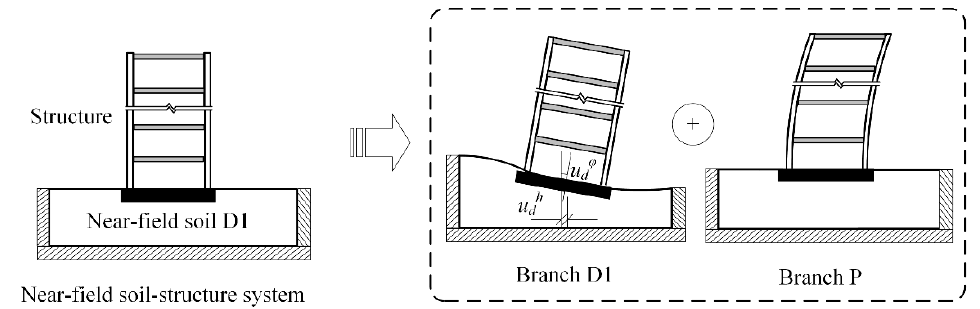
Figure 4. Derivation principle of the motion equation of the soil–structure system. Based on the same method as that used in the D2 region, the computational matrix of the near-field in D1 was subdivided into blocks with internal (i) and boundary (b) de- grees of freedom. The modal information was obtained according to the constrained mode method, and the coordinate transformation was carried out. The transformed